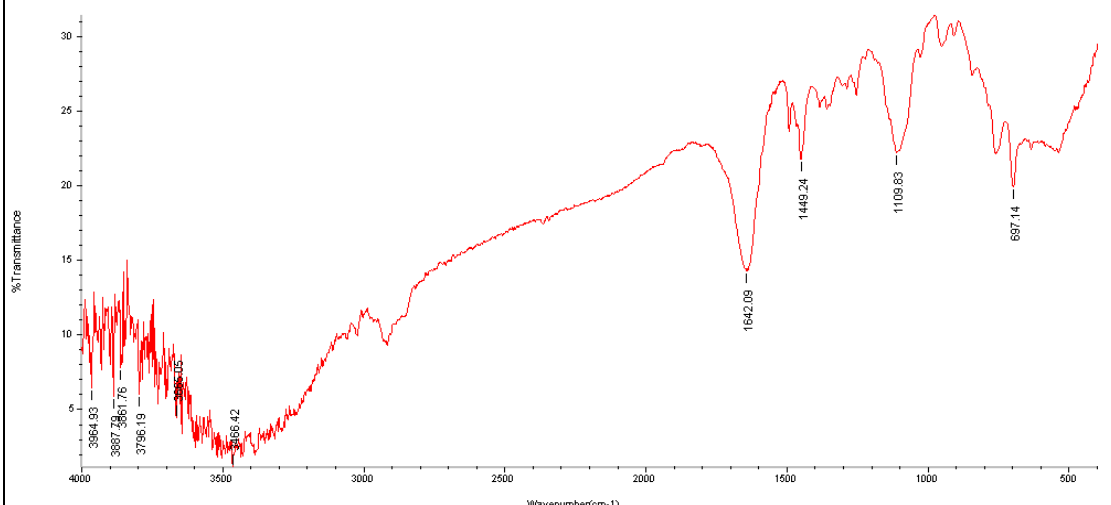
Figure 6. FTIR spectrum of lyophilized powder